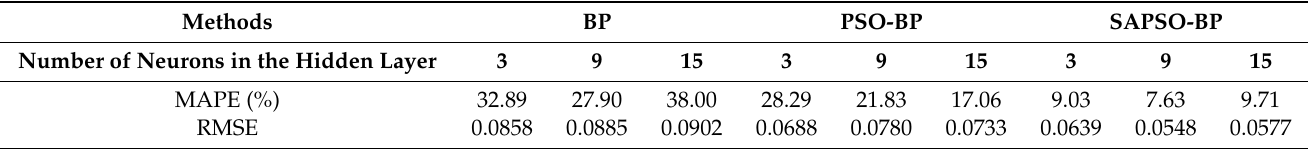
Table 6. MAPE and RMSE of 9